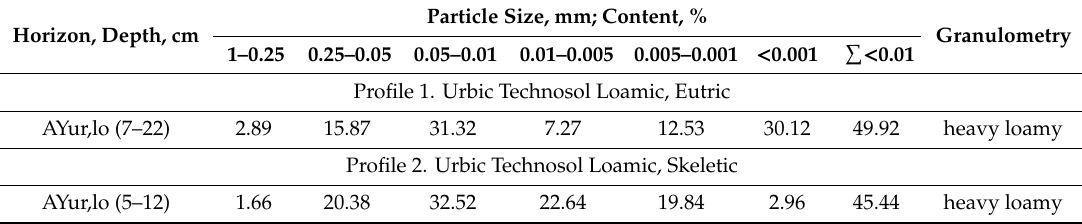
Table 1. Granulometry of the upper soil horizons of soils of Gubakha. Horizon, Depth,